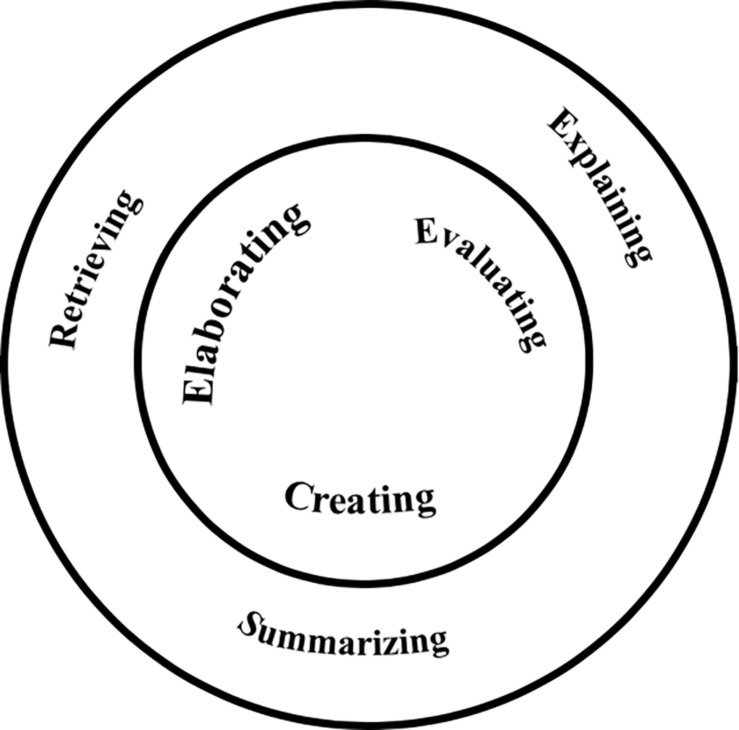
Dual-layer circle.